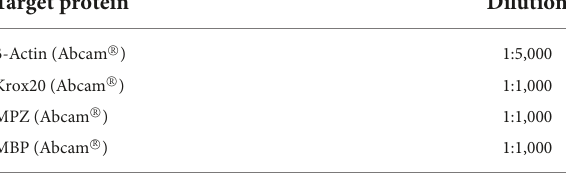
TABLE 1 Primary antibodies used for protein detection. Target protein